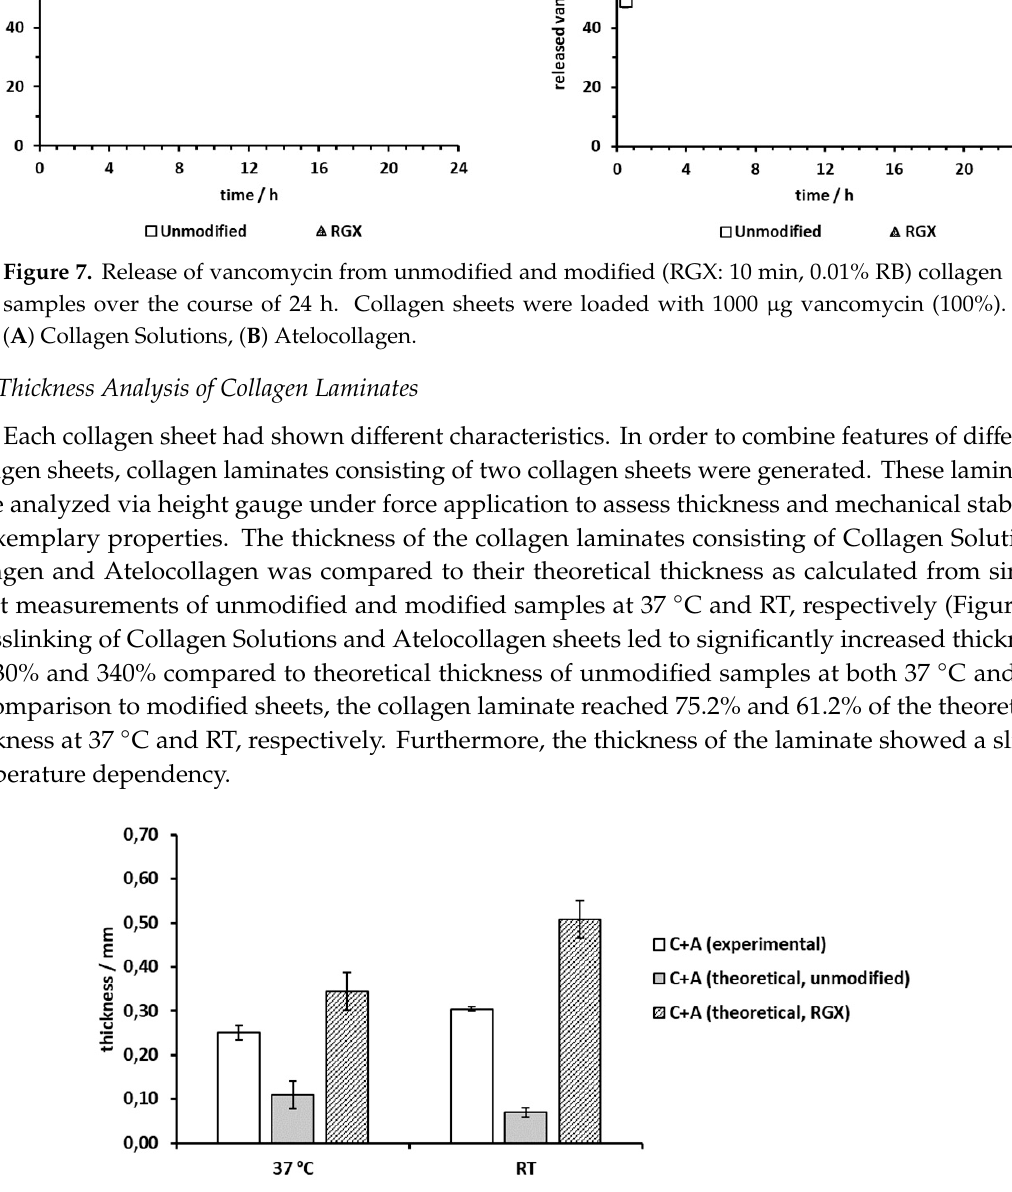
Figure 8. Thickness of collagen laminates consisting of Collagen Solutions collagen (C) and Atelocollagen (A) prepared by RGX (10 min, 0.1% RB) compared to their theoretical thickness (sum of thicknesses of collagen single sheets) of unmodified and modified samples (RGX) at 37 °C and RT. Samples were conditioned in PBS for 24 h before measurement.